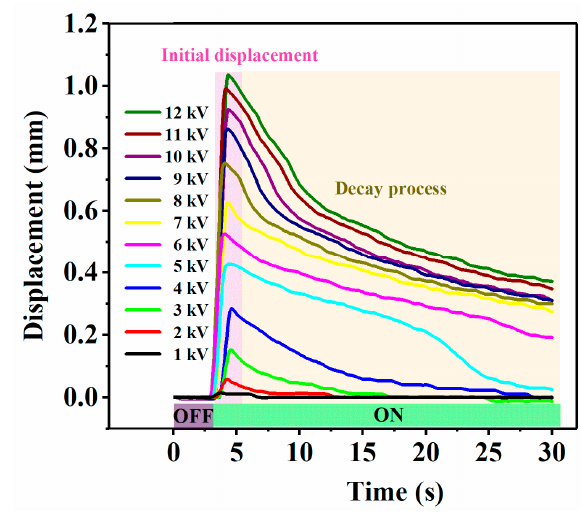
Figure 4. The output displacement of the actuator under different DC voltages over time.